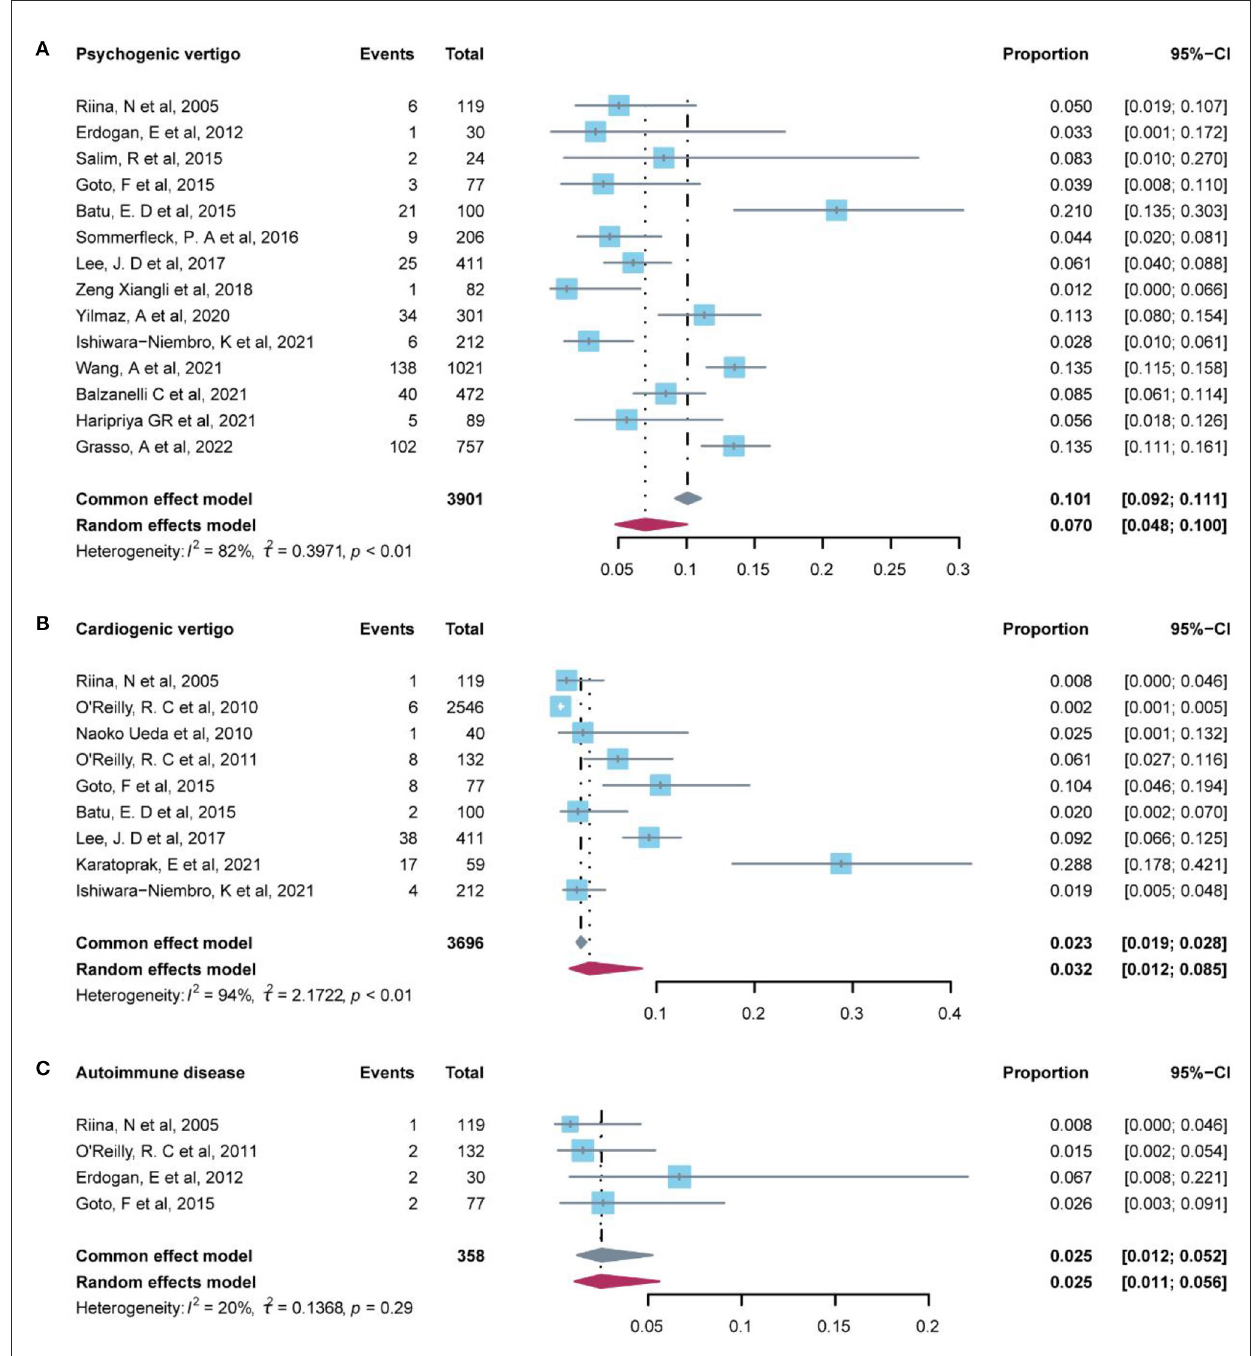
FIGURE4 Forest plot of psychogenic vertigo and common diagnosis in other systematic disease.